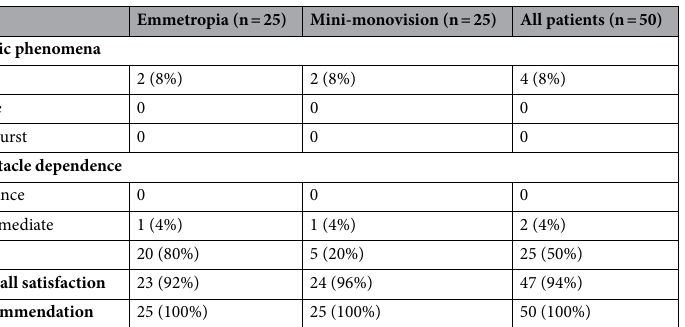
Table 3. Results of the patient questionnaire regarding visual symptoms, spectacle dependence, overall satisfaction, and recommendations in patients implanted with the Eyhance ICB00 intraocular lens. Data are expressed as frequency